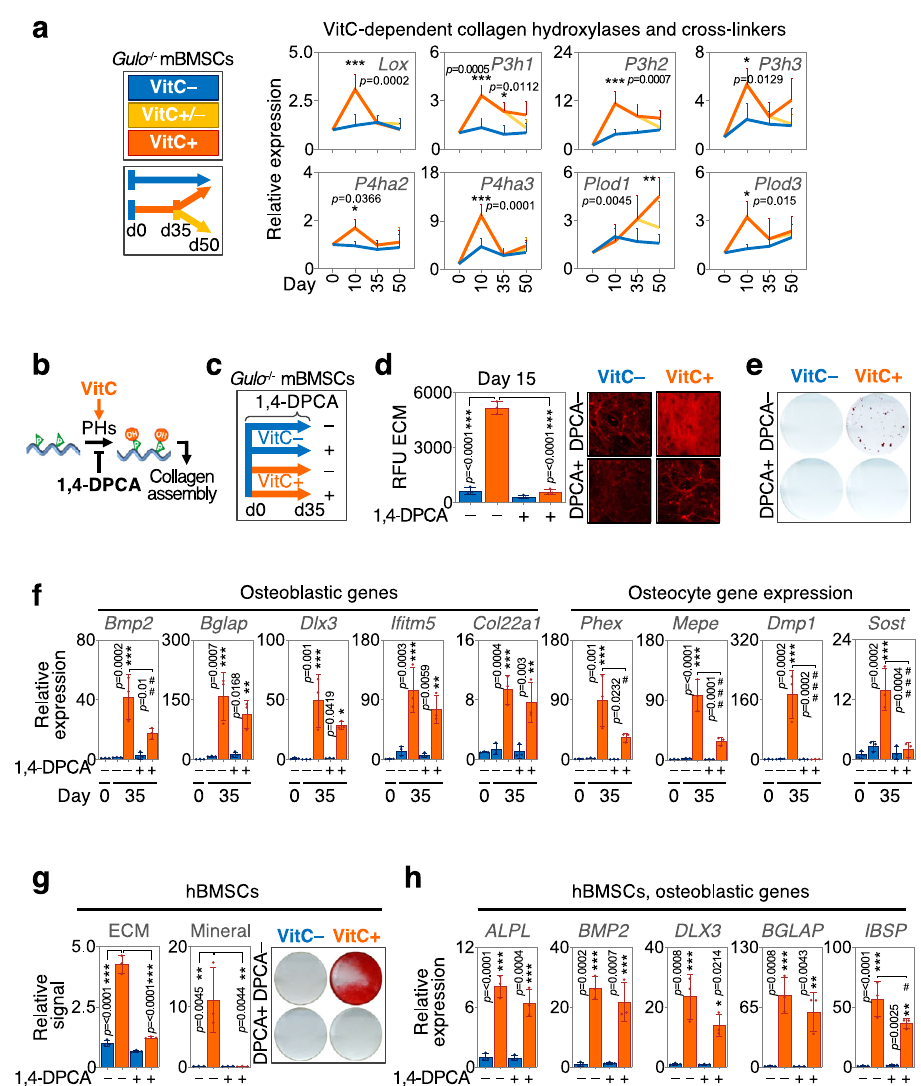
Fig. 5 | Vitamin C-dependent collagenous matrix formation is dispensable for VitaminC-mediatedosteoblasticgeneexpression.a Geneexpressionofcollagen hydroxylases and cross-linkers in BMCSs from 5-week VitC-de fi cient Gulo – / – mice cultured in the presence or absence of VitC, or treated with VitC until day 35 after whichVitCwasremoved. b InhibitionofVitC-dependentextracellularmatrix(ECM) deposition by 1,4-DPCA. c Experimental setup using 1,4-DPCA during VitC-induced osteogenic differentiation. d – f Effects of 1,4-DPCA on ECM deposition (RFU, rela- tive fl uorescenceunits)( d ),ECMmineralization( e )andosteogenicgeneexpression ( f ); VitC-untreated BMSCs at day 0 were used as an additional control. g Effects of 1,4-DPCA on ECM deposition and ECM mineralization in human BMSCs during